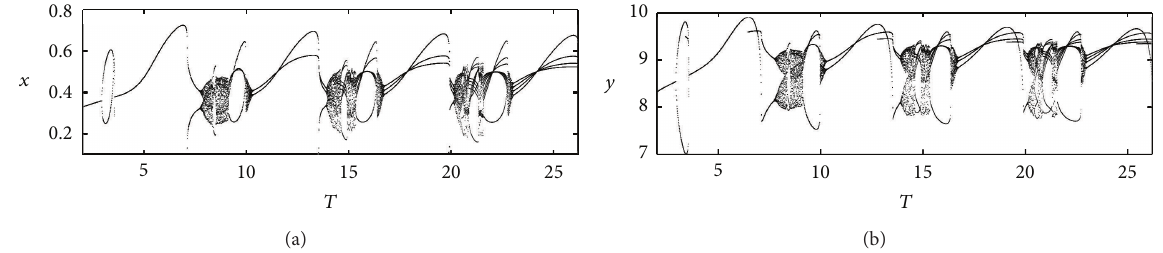
Figure 2: Bifurcation diagrams of model (24) with respect to bifurcation parameter 𝑇 , where all parameter values are fixed as follows: 𝑎 = 8 , 𝑏 = 5 , 𝑐 = 1 , 𝜔 = 1 , 𝜇 = 0.95 , 𝑑 = 0.2 , 𝜎 = 0.5 , 𝑝 max population 𝑦 with 𝑇 .